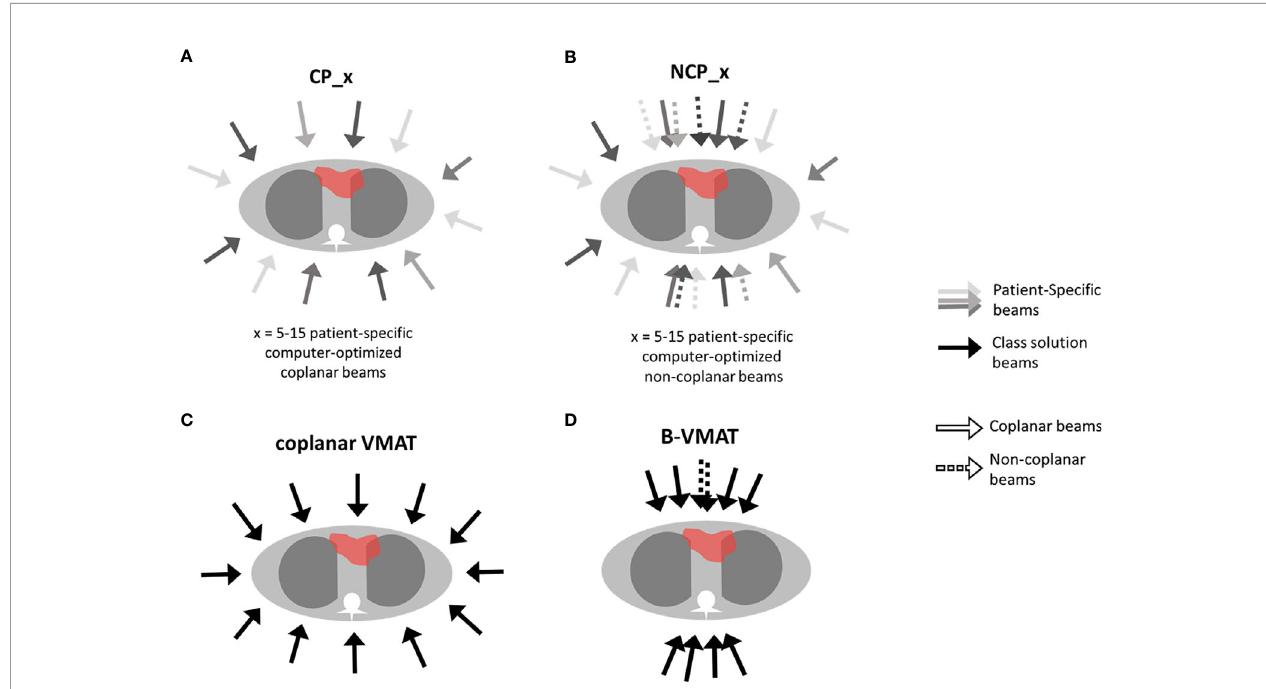
FIGURE 1 | Schematic representation of the investigated beam con fi gurations: CP, coplanar (A) , NCP, non-coplanar (B) , coplanar VMAT (C), and B-VMAT, Butter fl y-VMAT (D)